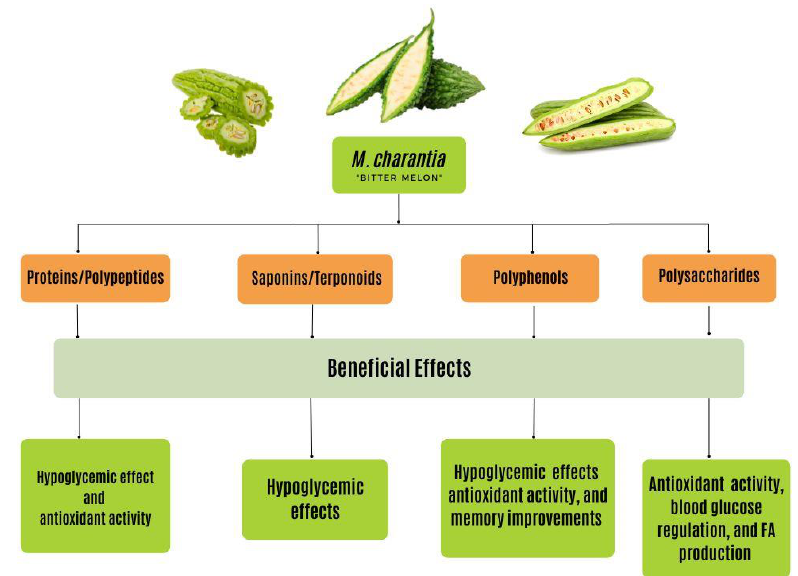
Figure 4. The beneficial effects of bioactive compounds found in M. charantia have various effects on chronic disease states, including T2DM and AD. These effects include hypoglycemic, antioxidant, blood glucose regulating, FA production, and memory-enhancing effects. These effects stem from the proteins, saponins, polyphenols, and polysaccharides found within this plant. Through the consumption of this plant, the beneficial effects are activated from the bioactive compounds. T 2DM, type 2 diabetes mellitus; AD, Alzheimer’s disease.